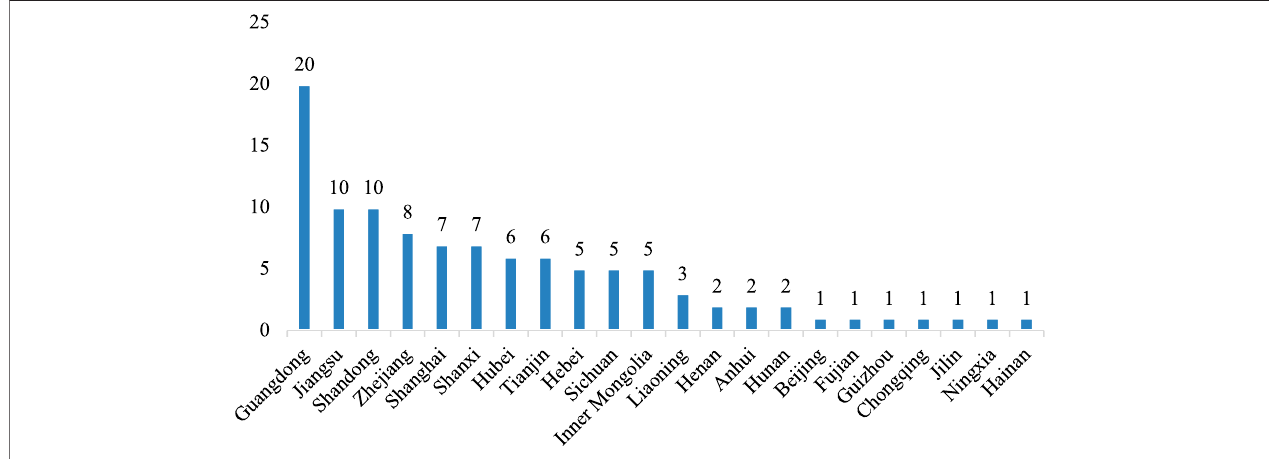
FIGURE 3 | The number of HFCV-related local supporting policies issued by China ’ s province (2017 – 2020). Data source: Each of fi cial local government department website of issued policies.